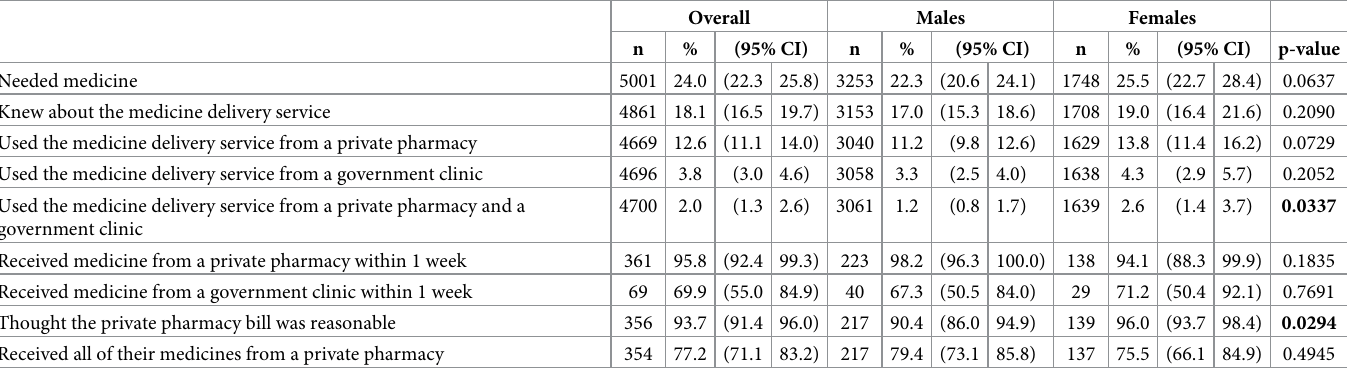
Table 6. Sri Lanka COVID-19: Survey